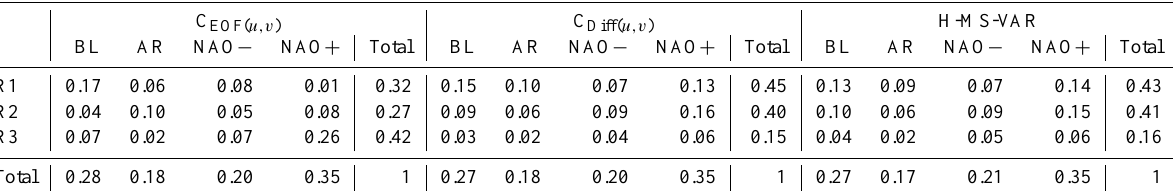
Table 3. Joint probability of occurrence of the three local regimes identified by the proposed models in rows and the four large-scale regimes in columns.